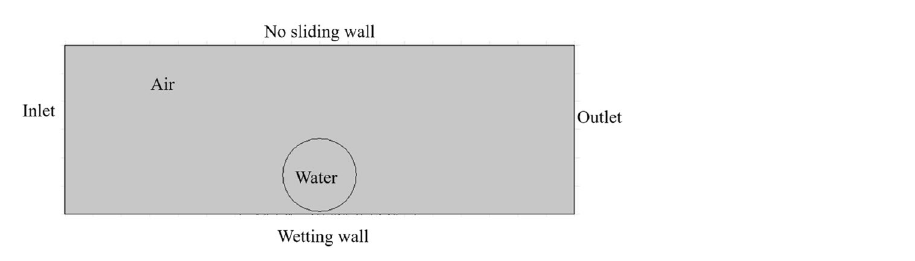
Figure 8. Boundary conditions of the